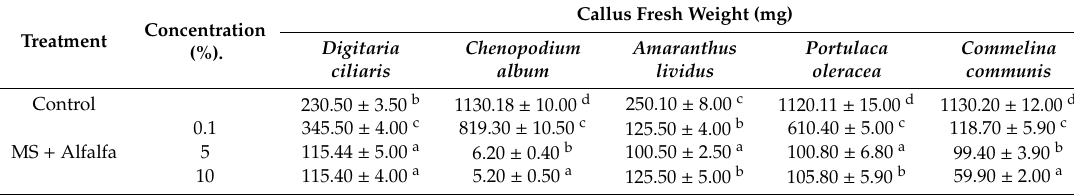
Table 1. E ff ect of alfalfa leaf extracts on callus fresh